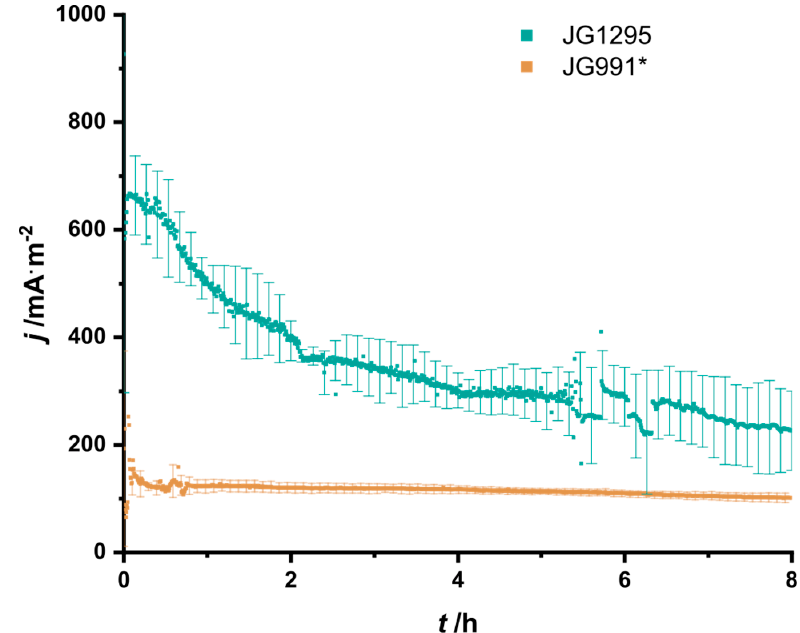
Figure 5. Chronoamperometric detection. Electro-fermentation in MOPS buffered medium supplemented with 10 mmol/L glucose and 0.1% yeast extract. Displayed is the current density over time for the previous production strain (JG991, yellow) and the newly adapted strain (JG1295, teal). * data originally published in [22] and added here as a reference for the performance of the newly adapted strain.